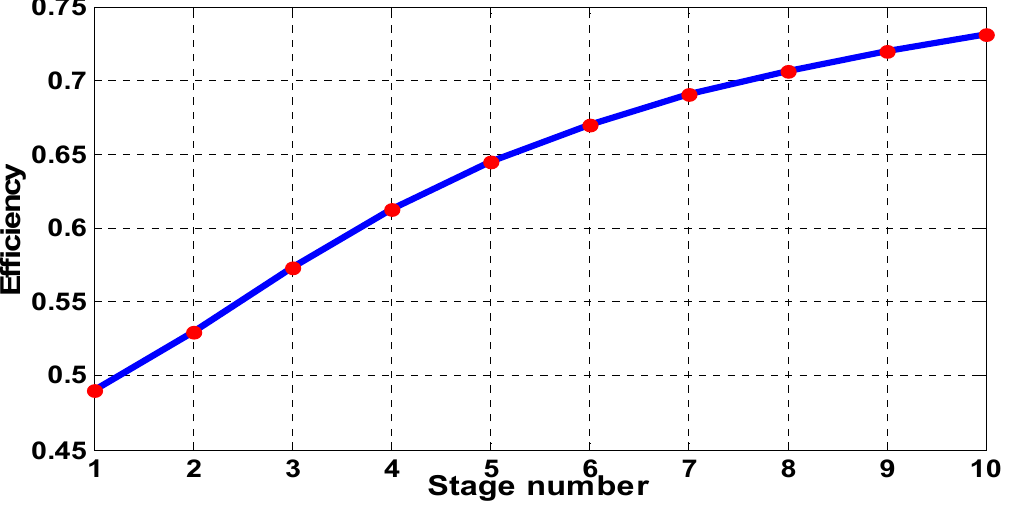
Figure 7. Change in efficiency with different compression